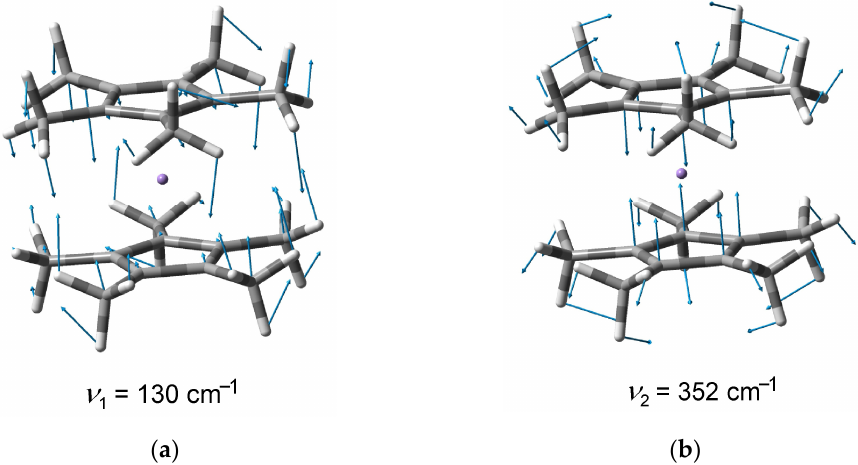
Figure 4. Relative atomic shifts corresponding to the ν 1 (a) and ν 2 (b) vibrations of the Cp* 2 Mn +